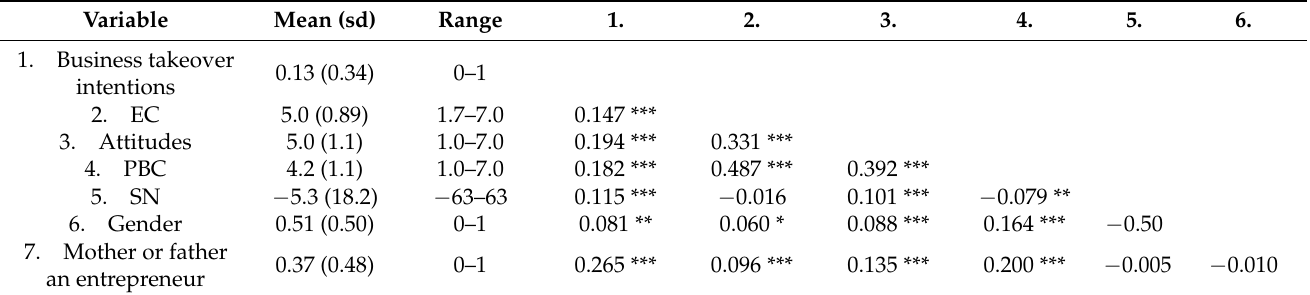
Table 2. Correlations, means, standard deviations, and ranges of the